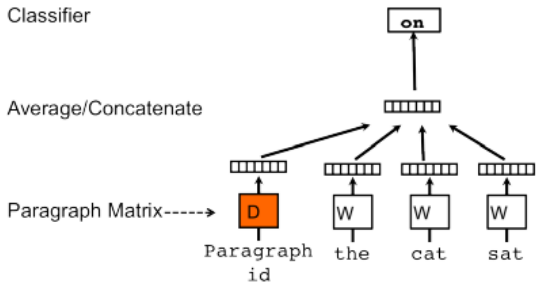
Figure 1. Distributed Memory Model of Paragraph Vectors